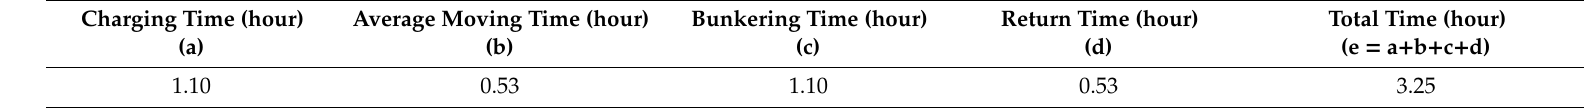
Table A9. Estimated Time Required for One TTS Bunkering.